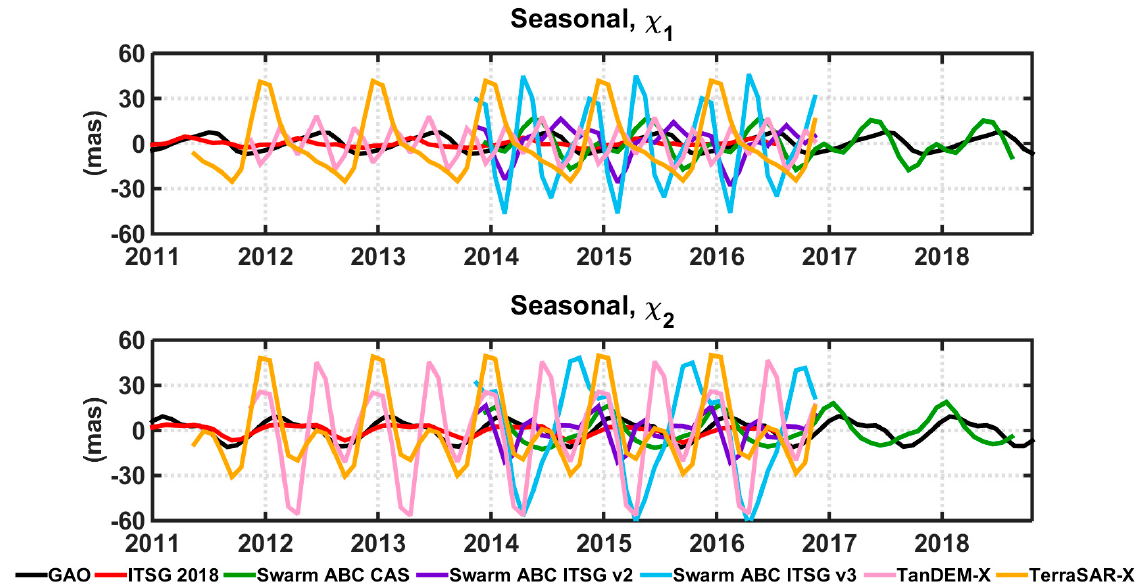
Figure 2. The χ 1 and χ 2 seasonal components of GAO and HAM obtained from: (1) ITSG 2018 GRACE solution (ll-SST), (2) solutions based on kinematic orbits of Swarm ABC, TanDEM-X, and TerraSAR-X satellites (hl-SST).